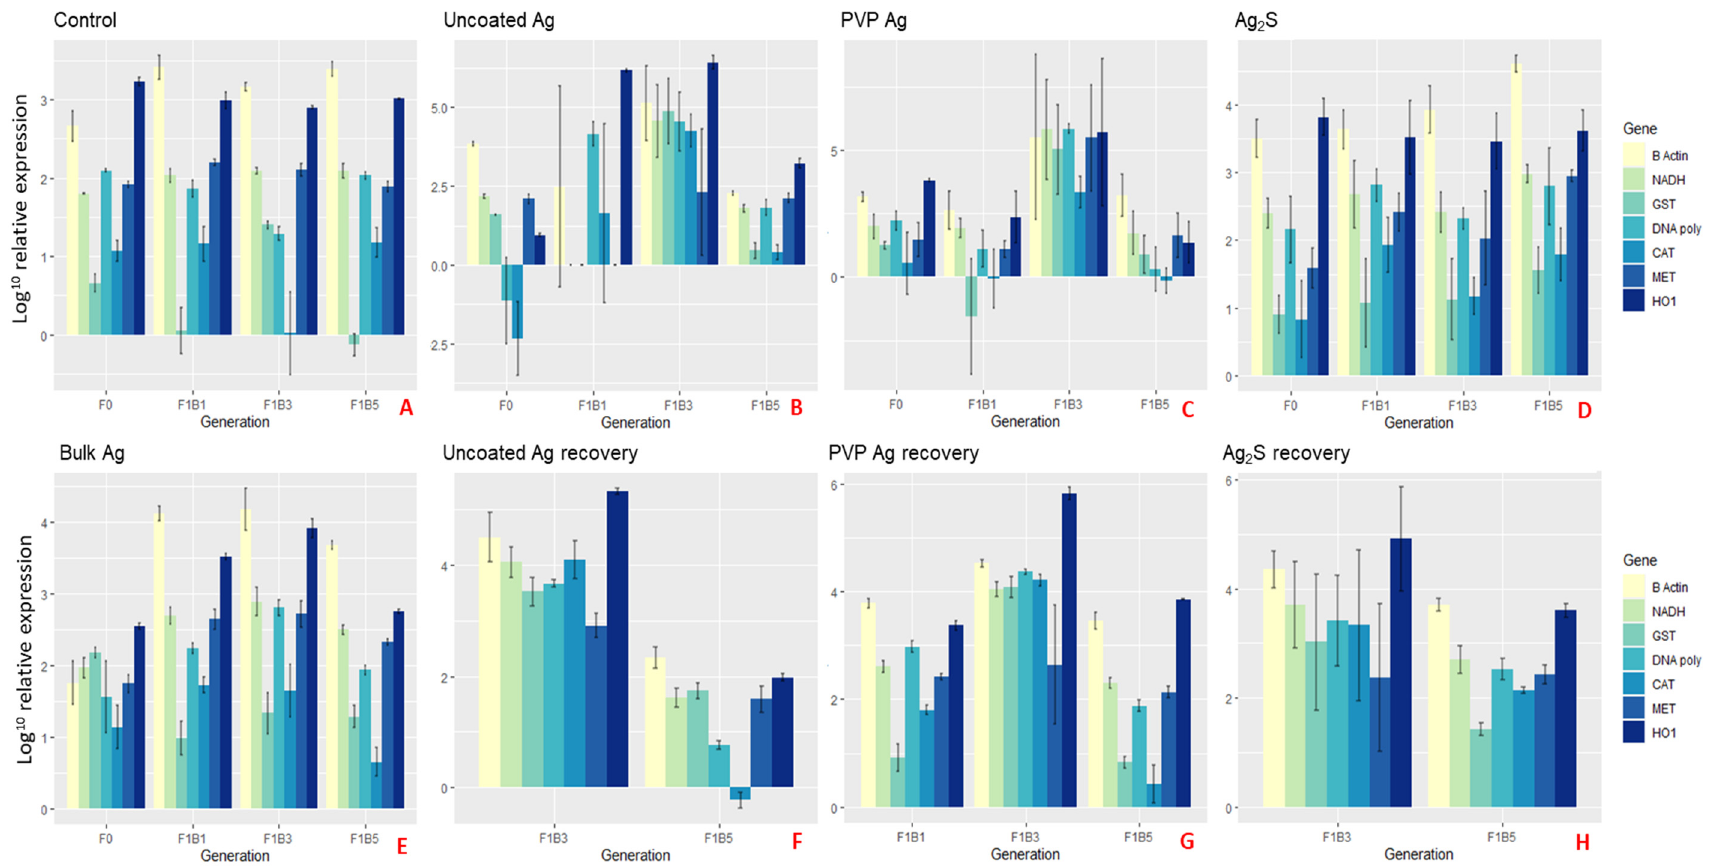
Figure 5. Gene expression barplots of the average relative expression (Log 10 ) for parent (F0) Daphnia controls ( A ) or exposed to the different Ag NMs ( B–D, F–G ) or bulk silver ( E ), and the relative gene expression levels of the first (F1B1), third (F1B3) and fifth (F1B5) broods born of the F0 Parent in either continuous exposure ( B – E ) or removed for recovery ( F – H ), determined after 24 h. Error bars show the standard deviation and the NM gene interaction statistics are presented in Table S34 in the supplementary information. p ≤ 0.05 was considered statistically significant. Key = Glutathione S-transferase (GST), dehydrogenase (NADH), β -Actin (B-Actin), catalase (CAT), metallothionein (MET), DNA Polymerase (DNA-poly) and heme-oxygenase-1 (HO1). All genes are normalised to 18S ribosomal RNA (18S).